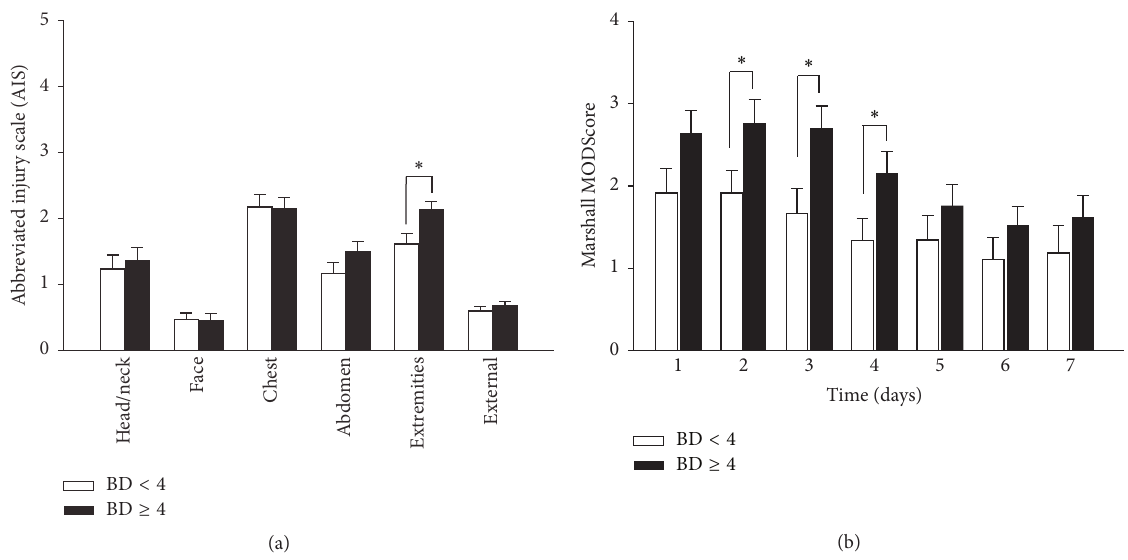
Figure 3: (a) Abbreviated injury scale (AIS) analysis of injury patterns in BD ≥ 4 and BD < 4 subgroups. The BD ≥ 4 group exhibited greater extremity injury when compared to the BD < 4 group. ∗ 𝑃 < 0.05 by Mann–Whitney U test. (b) Multiple Organ Dysfunction Score (MODScore) in BD ≥ 4 and BD < 4 subgroups from days 1 through 7 after injury. The BD ≥ 4 group had a statistically significantly higher degree of organ dysfunction from days 2 to 4 after injury compared to the BD < 4 group. ∗ 𝑃 < 0.05 by two-way ANOVA.